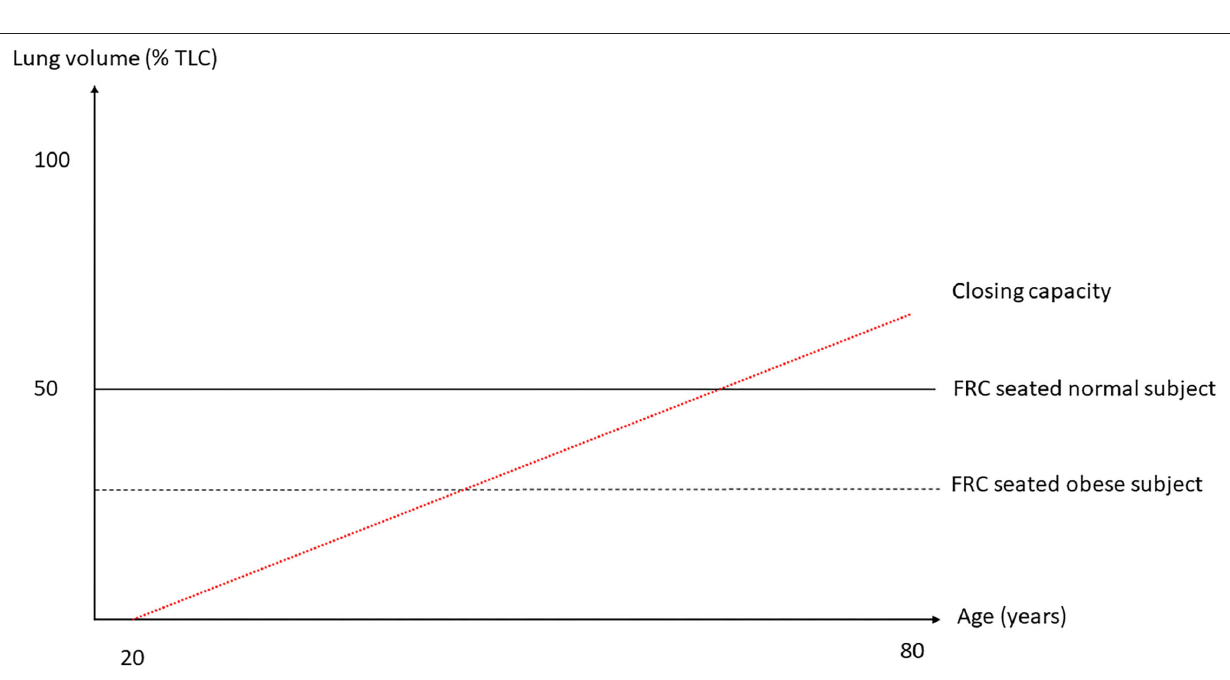
of that resistance to collapse may result from the erectile effect of vascular distension at low lung volume that tethered the peripheral airways (Goldberg et al., 1975). The sequence of closure, airways then alveoli, allows gas exchange to continue